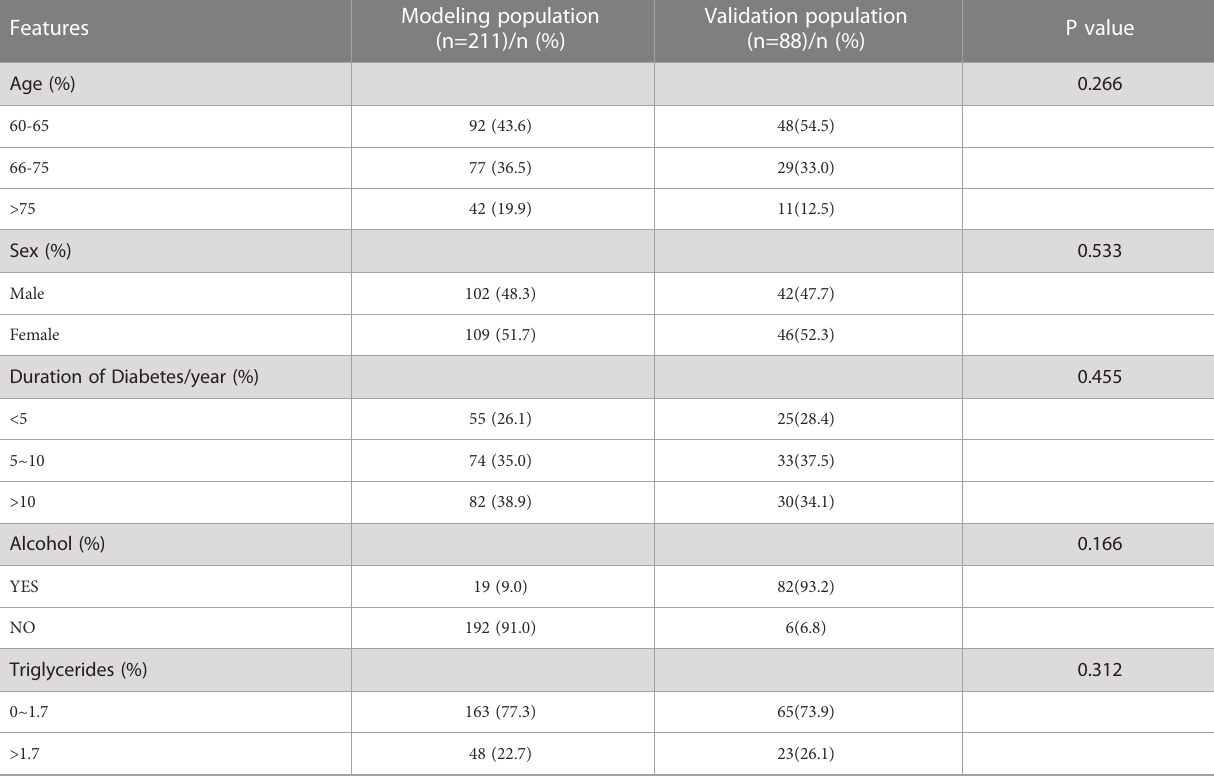
TABLE 1 Patient demographic characteristics of the modeled